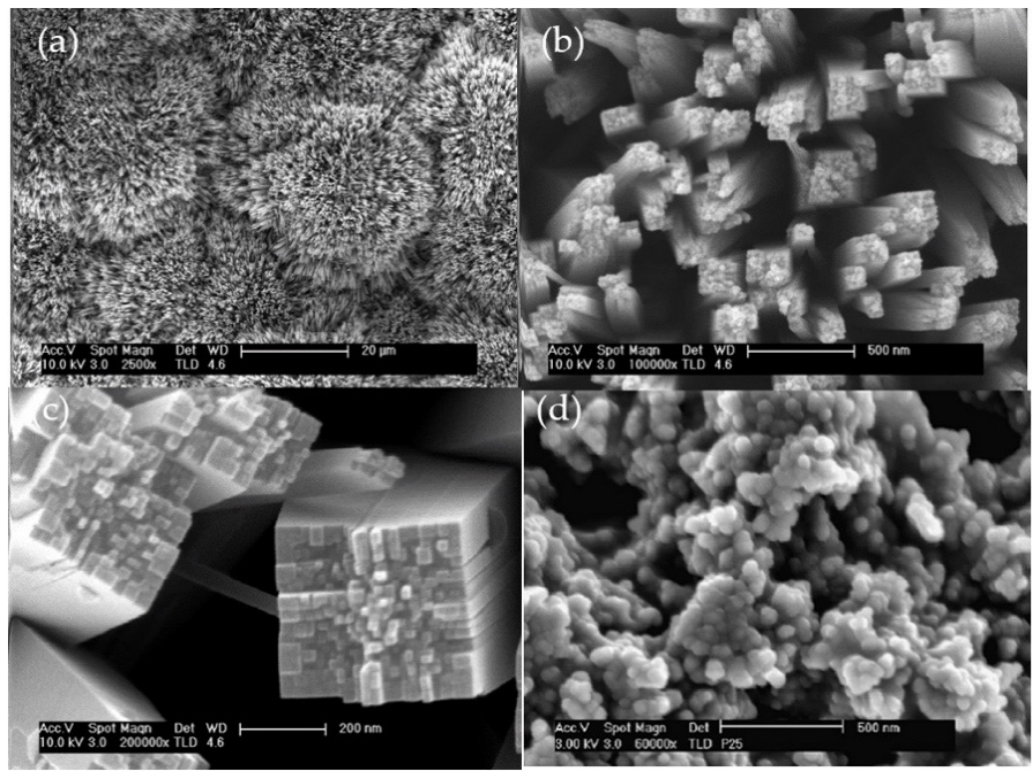
Figure 1. FE-SEM micrographs of TiO 2 NW ( a – c ) and its commercial form (TiO 2 -P25) ( d ), at different magnifications. Table 1. Brunauer, Emmett and Teller (BET) surface area of catalysts containing silver and MoS 2 *.